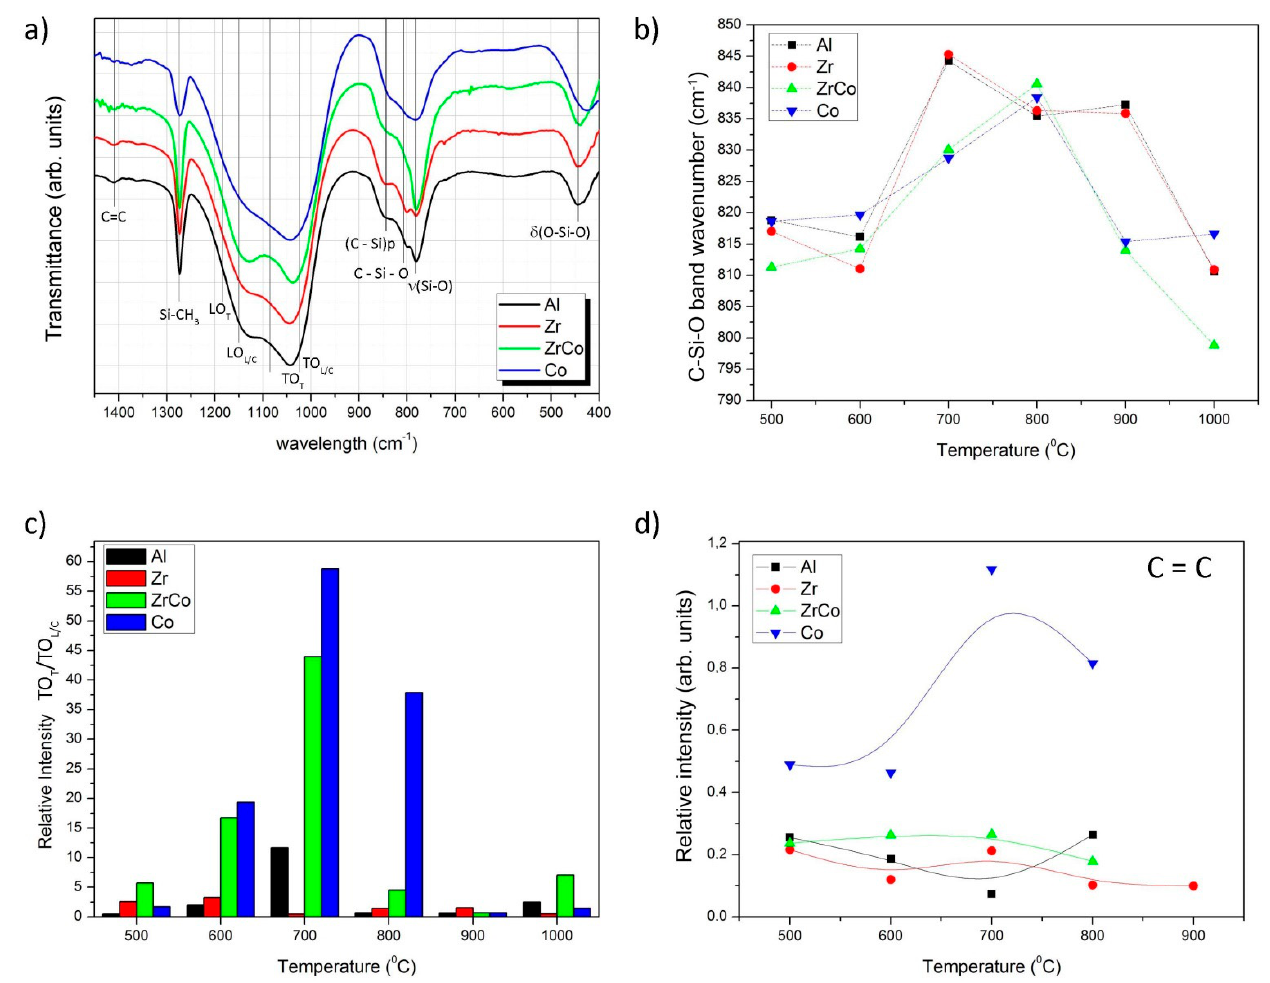
Figure 2. ( a ) FTIR spectra of the samples pyrolyzed at 700 °C; ( b ) position of the band corresponding to the formation of SiOC bonds as a function of the temperature; ( c ) relative intensity ratio of the bands assigned to the stretching mode of the superstructural rings forming tridimensional (T) and chains (L/C); ( d ) relative intensity of the bands assigned to the asymmetric stretching of double-bonded carbon. This intensity was normalized to the area of the band at 1080 cm − 1